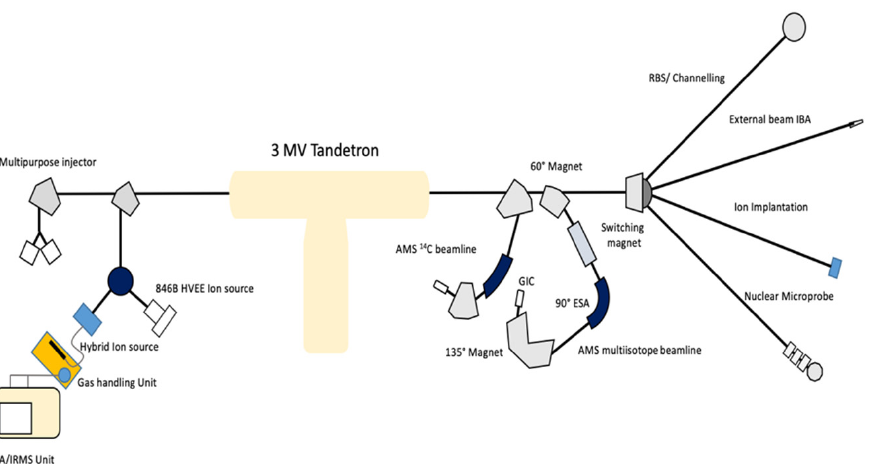
Figure 2. Schematic of the accelerator-based facility at CEDAD-University of Salento. One of the six experimental beamlines is dedicated to 14 C dating.